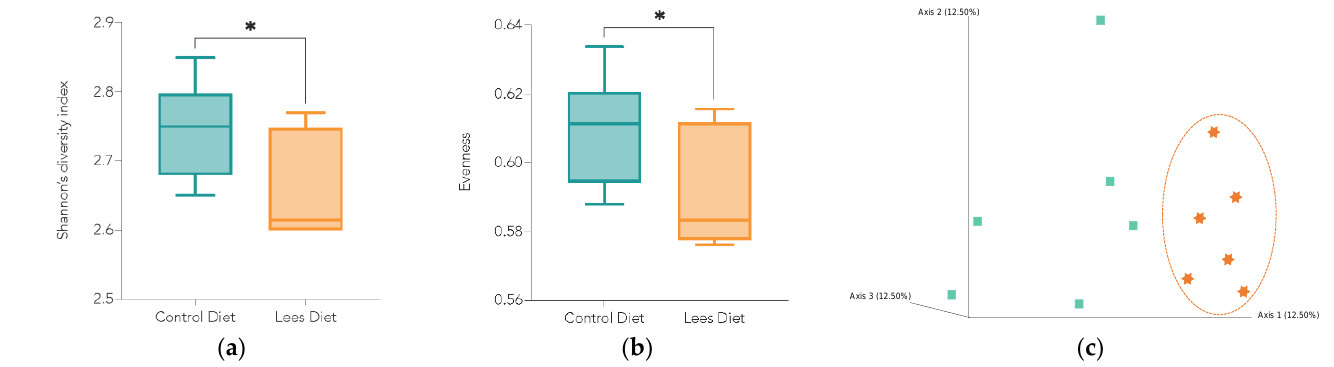
Figure 4. Alpha and beta diversity between animals with control (green) and lees (orange) diet. Significant differences between groups are indicated with an asterisk (*): ( a ) Shannon diversity index (alpha diversity); ( b ) evenness (alpha diversity); ( c ) beta diversity between animals with control (green squares) and lees (orange stars) diet determined by the Bray–Curtis index and principal coordinates analysis (PCoA).